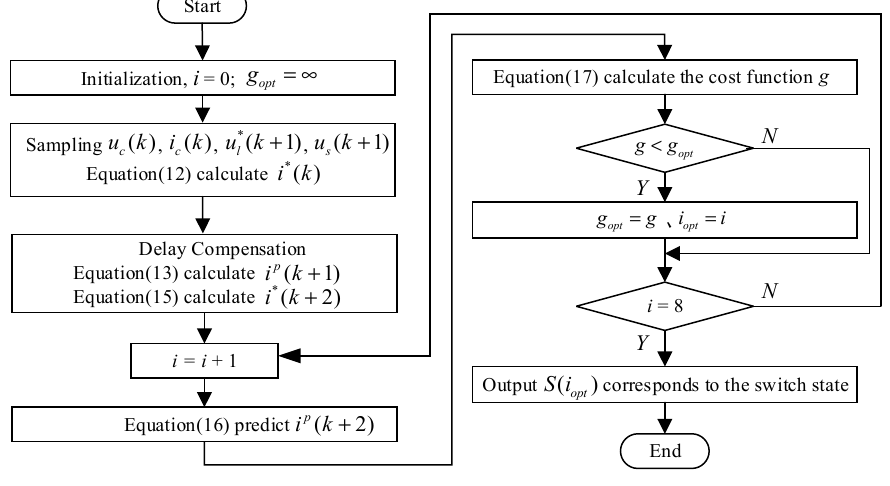
Figure 5. Control block diagram of SAPF system based on the DBDC-FCS-MPC strategy.